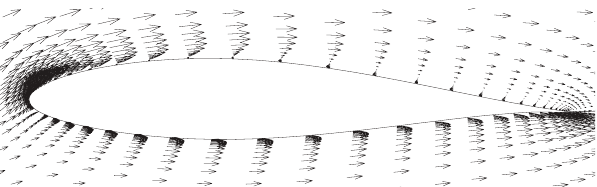
Figure 19: Very thin separation bubble solved by the unsteady laminar model at 𝑟/𝑅 = 0.91 for 𝜆 = 5